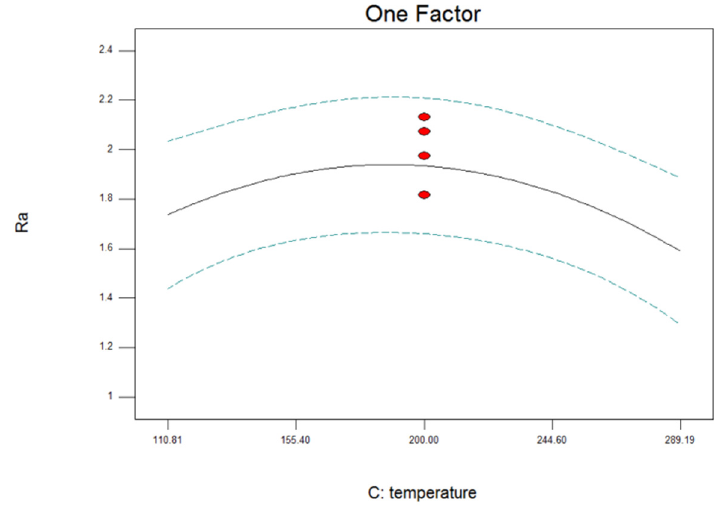
Figure 8. Temperature response curve.